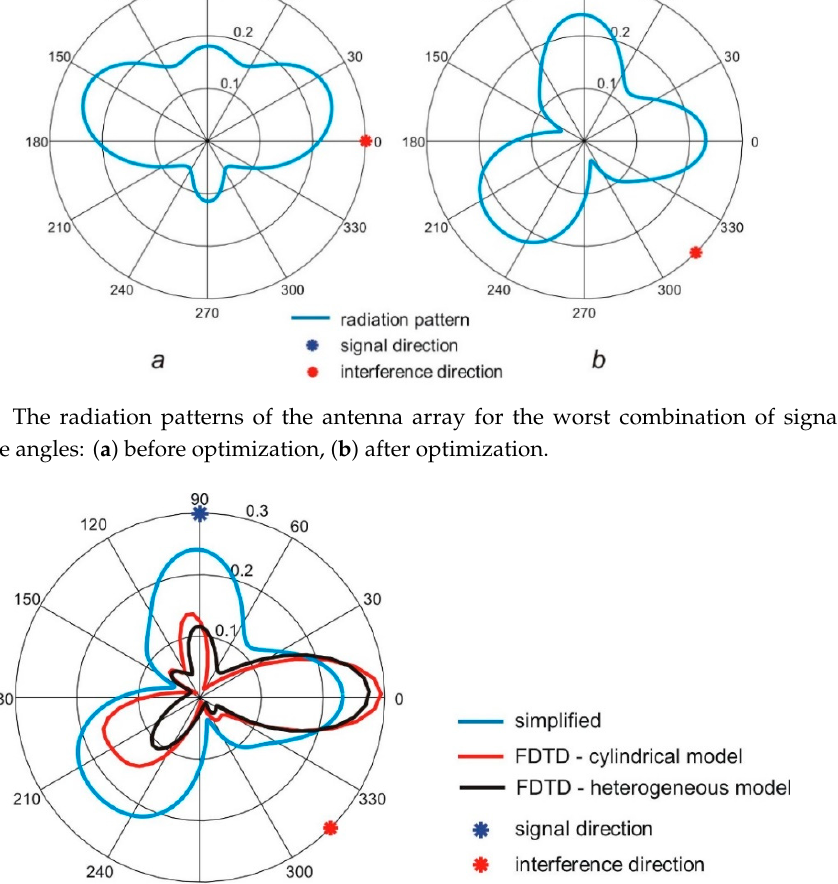
Figure 18. The radiation patterns of the optimized antenna array for the worst combination of signal and interference angles after optimization, obtained with the simplified model, cylindrical model, and heterogeneous model.